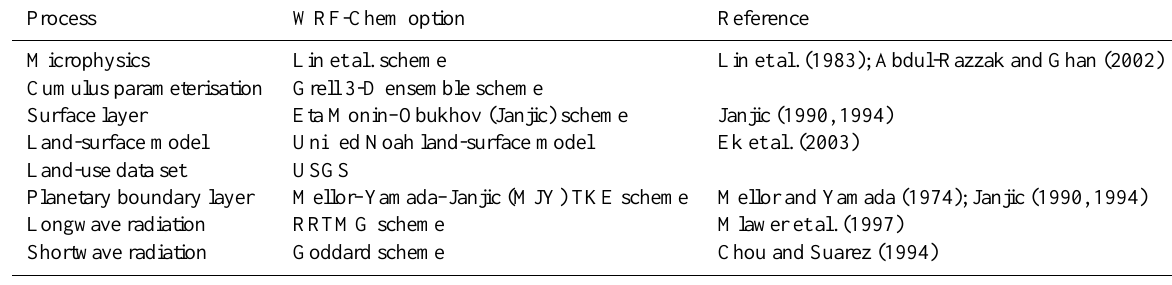
Table 2. Physical parameterisations used in the WRF-Chem model.